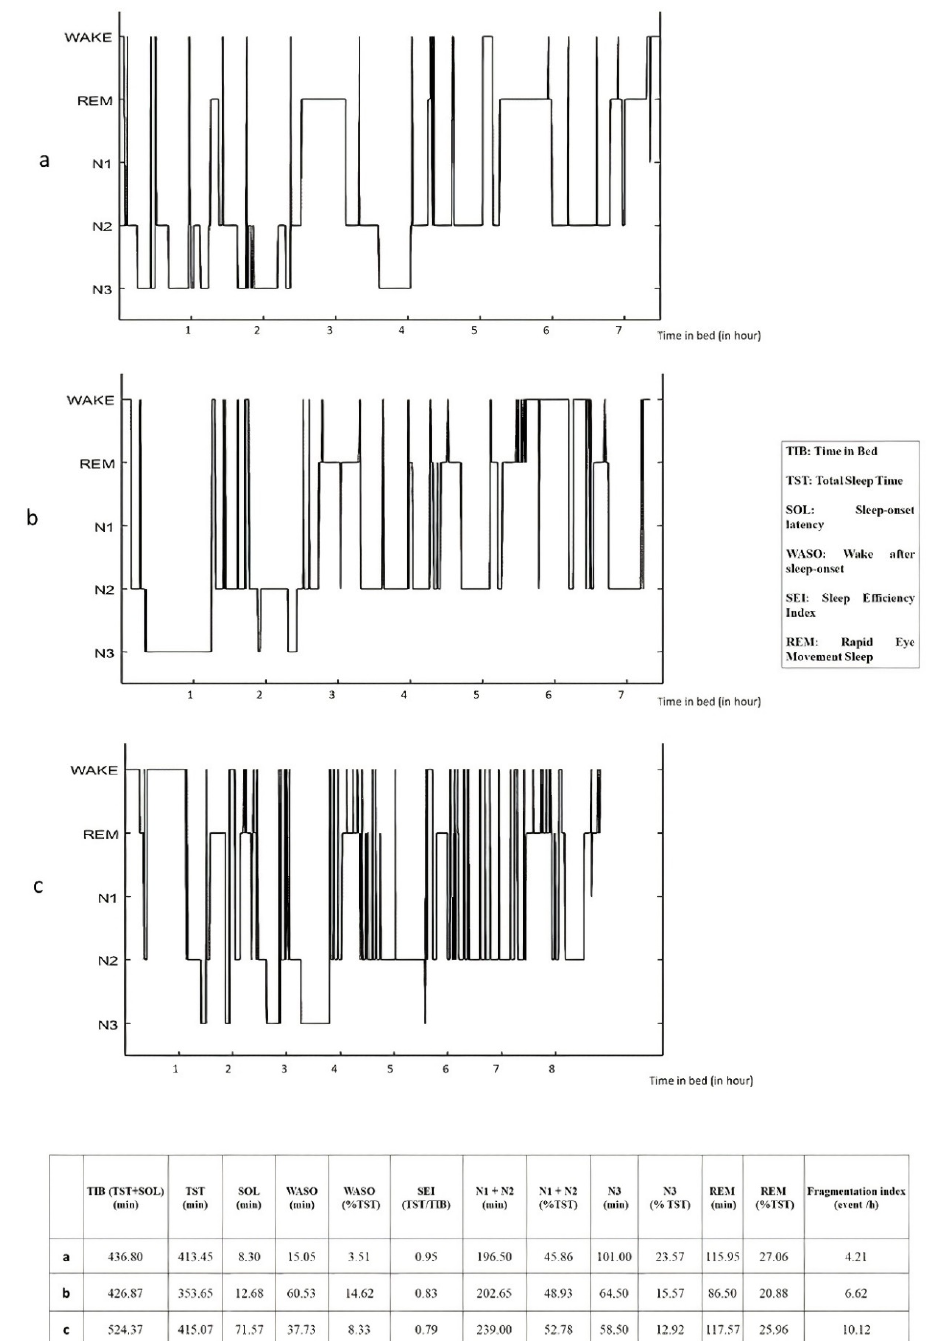
Figure 1. Hypnograms for one French soldier (35 years old) before ( a ) and after ( b ) deployment and one soldier with PTSD (36 years old) ( c ). Night sleep EEG recordings were performed using the ambulatory wireless dry-EEG device, the Dreem Headband (DH), with automatic sleep staging classification (122). Fragmentation index is the total number of awakenings/shifts to Stage 1 (from deeper non-rapid eye movement [NREM] or REM sleep with 30 s per epoch) divided by the total sleep time in hour. Other parameters are considered to reflect sleep fragmentation, such as increased WASO or a high percentage of the N1/N2 sleep stage, which usually results from frequent arousal. The figure shows that the veteran without PTSD has good sleep efficiency and a low fragmentation index prior to deployment. During deployment, there is an increase in fragmentation index and WASO associated with a decrease in sleep efficiency and N3 sleep. The veteran with PTSD has low sleep efficiency with a high fragmentation index. The percentage of REM is high while that of N3 is rather low. Unpublished data from ongoing clinical trial SOMMEPT (https://clinicaltrials.gov/ct2/show/NCT04581850) (accessed on 10 June